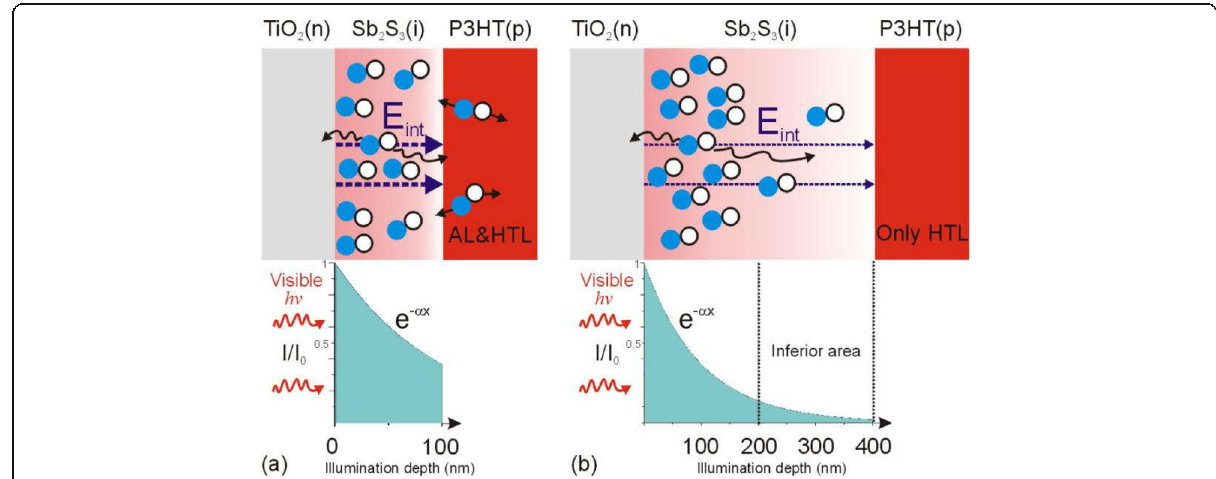
Fig. 6 The illustration of the Sb 2 S 3 thickness d -dependent illumination depth x and E in